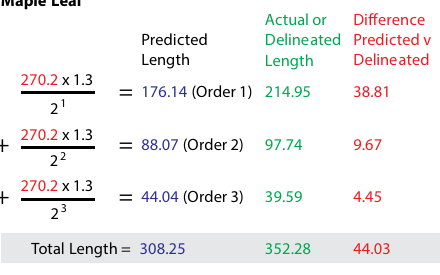
Figure 15, Maple Leaf Veins Network